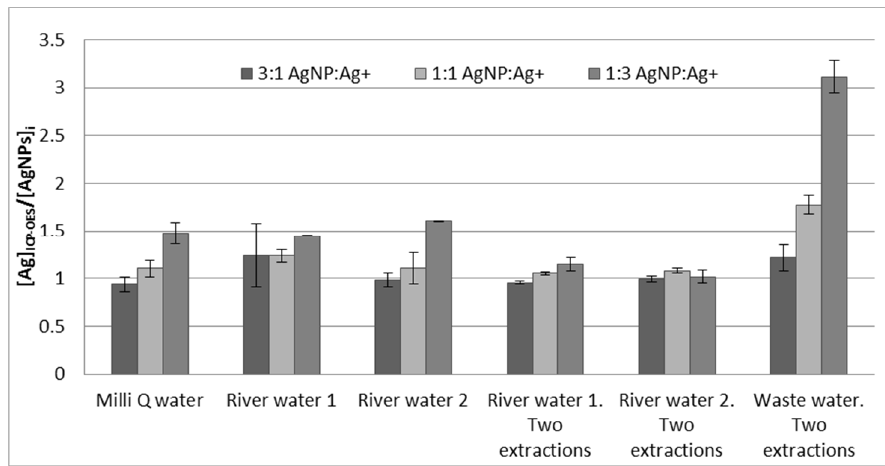
Figure 6. Total silver concentration measured by ICP-OES divided by AgNP initial concentration from mixtures of Ag + and AgNPs in different types of water samples using single and double extraction procedures. Error bars represent standard deviation, n = 2. Total initial silver concentration (Ag + + AgNPs) is 40 μg·kg − 1 for all mixtures of Ag + and AgNPs.